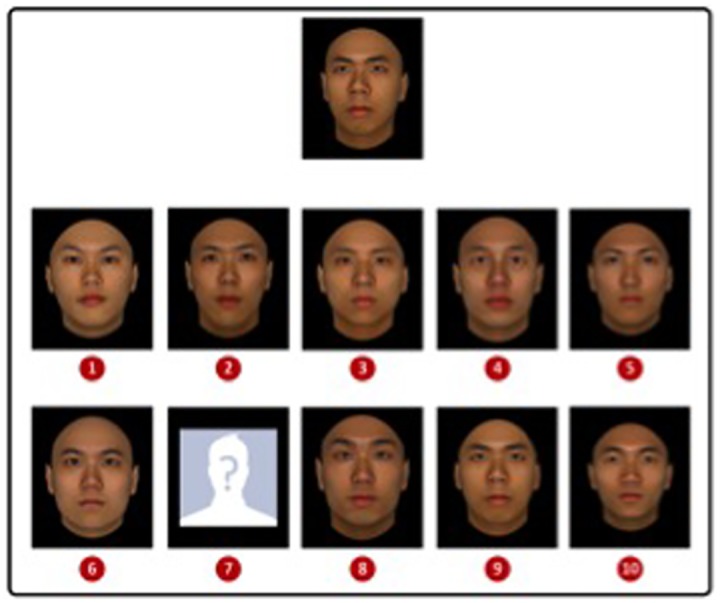
An example trial screen from Experiment 2 showing an Asian CGR target present trial.Participants were required to identify the target depicted at the top of the screen in the array below. The correct response in this example is 9.